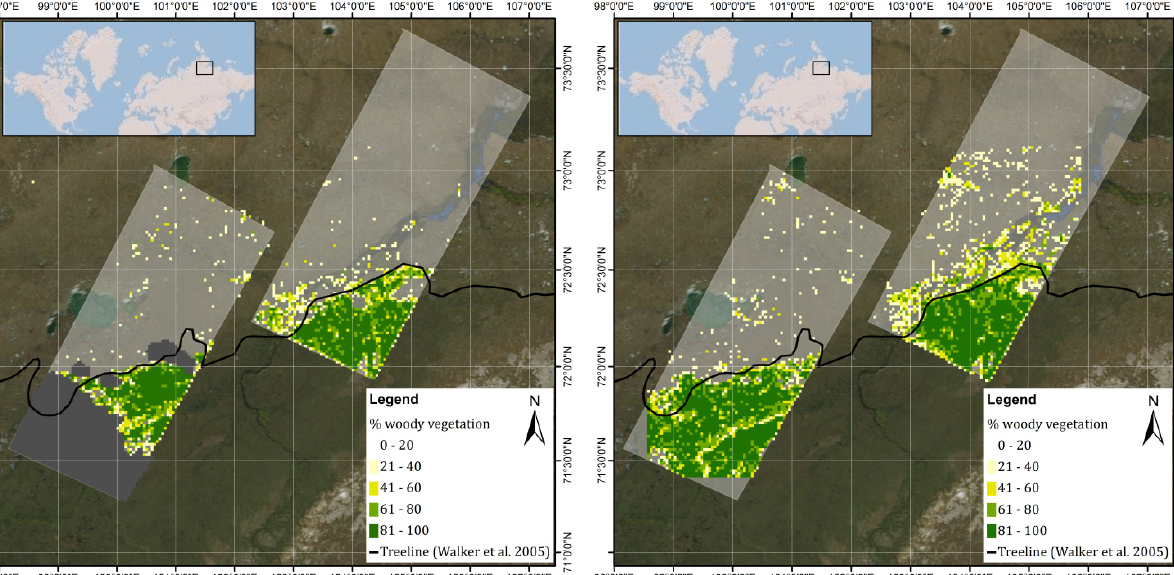
Figure 7. Landsat MSS and RapidEye woody vegetation cover (in % per 5 km grid cell) mapping between 1973 ( Left ) and 2012 ( Right )—background based on World Imagery by ESRI . The tree line reference from [58] is shown in black. Cloud regions in the Landsat MSS data are shown in